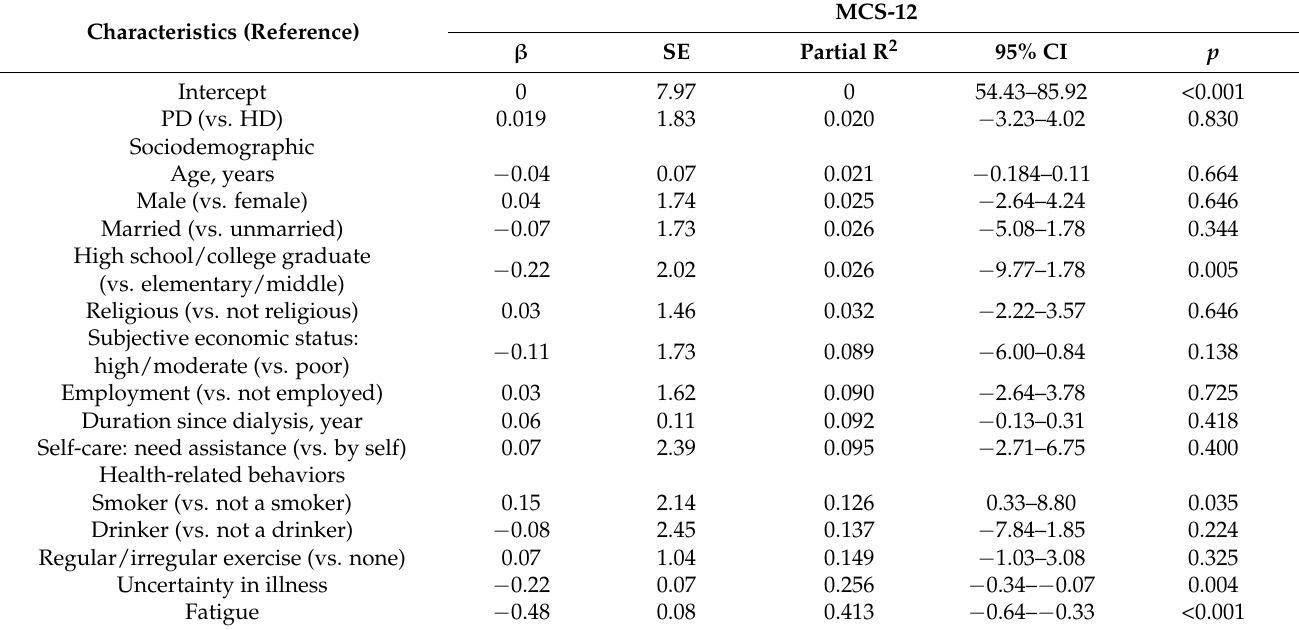
Table 4. Factors affecting mental health-related quality of life ( n =